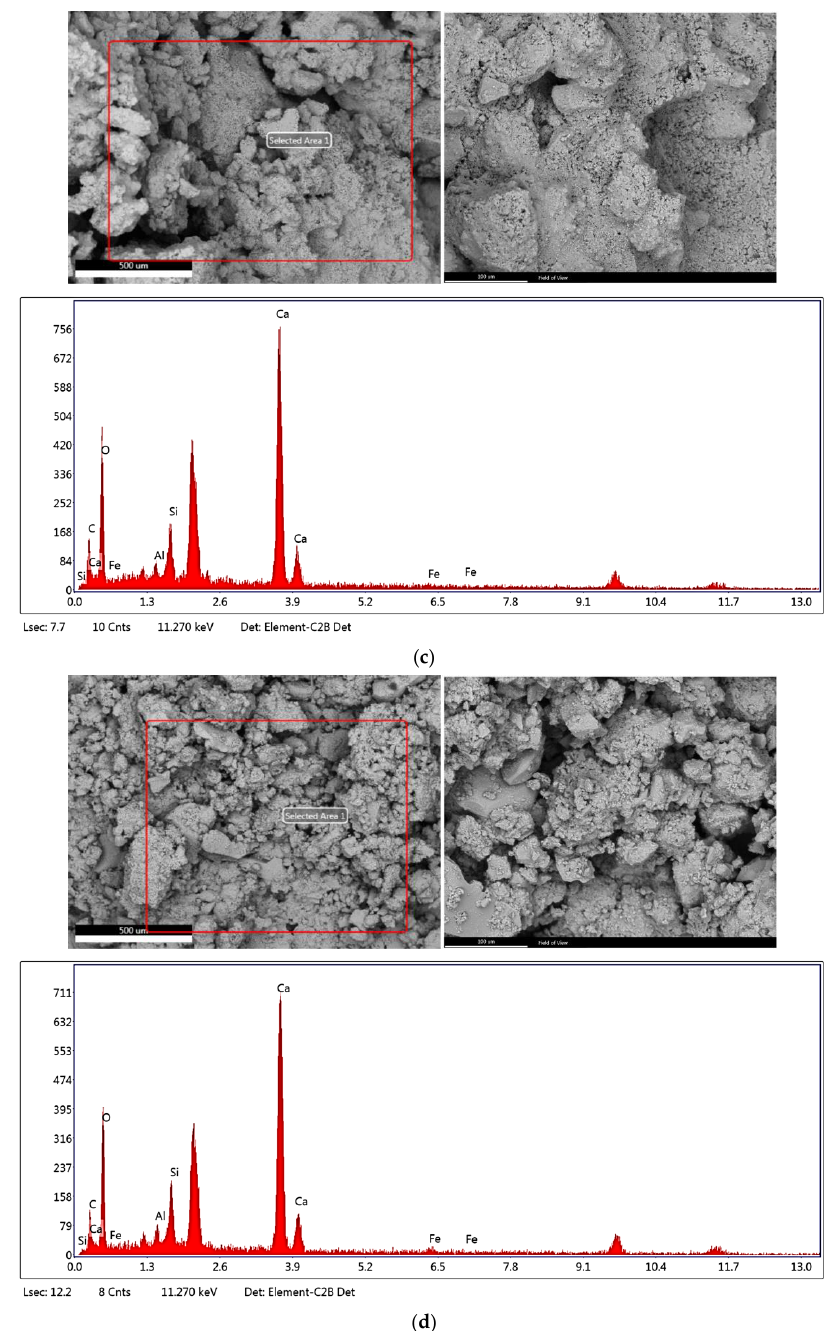
Figure 9. SEM images and EDAX analysis for different percentages of zeolite replacing cement and with 28 days’ treatment. ( a ) Zero replacement of zeolite instead of cement, ( b ) 20% replacement of zeolite instead of cement, ( c ) 30% replacement of zeolite instead of cement, ( d ) 40% replacement of zeolite instead of